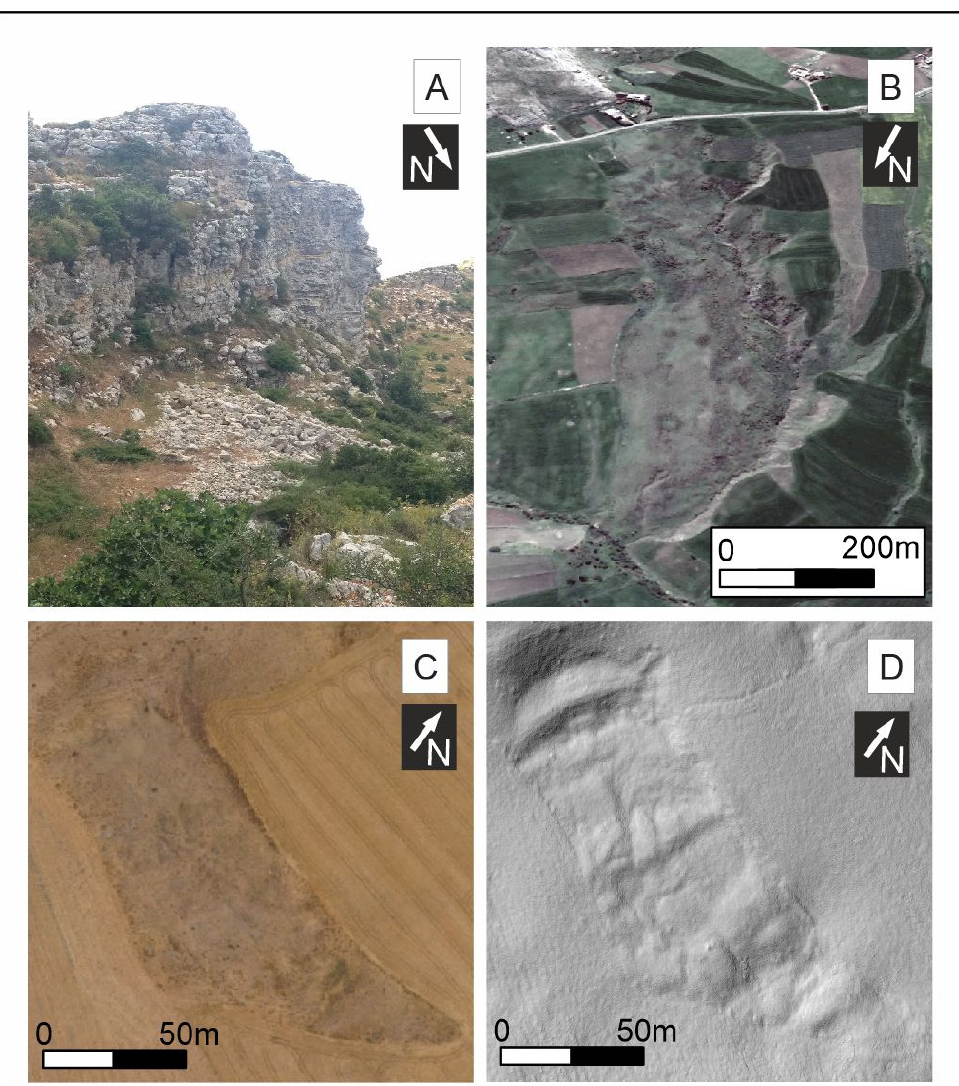
Figure 5. Landslide types observed in the region of Mateur. ( A ) Rockfall deposits at the foot of a scarp in the limestones of the Garia Formation. ( B ) Slow-moving flow developed in clays of the Haria Formation (Source: Google Earth™). ( C , D ) Orthoimage ( C ) and hillshade model ( D ) of a flow that occurred in a cereal crop adjacent to Chgega Mountain. Images obtained from the 3D model created in this study (see following sections for more